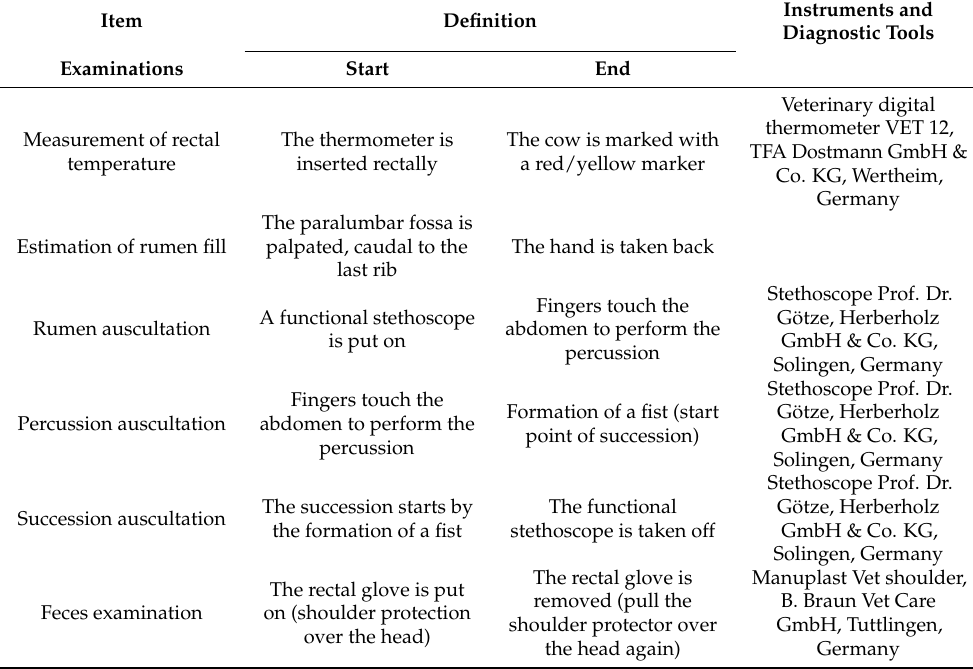
Table 1. Definition of start and end points for various examination steps, including the necessary diagnostic instruments and